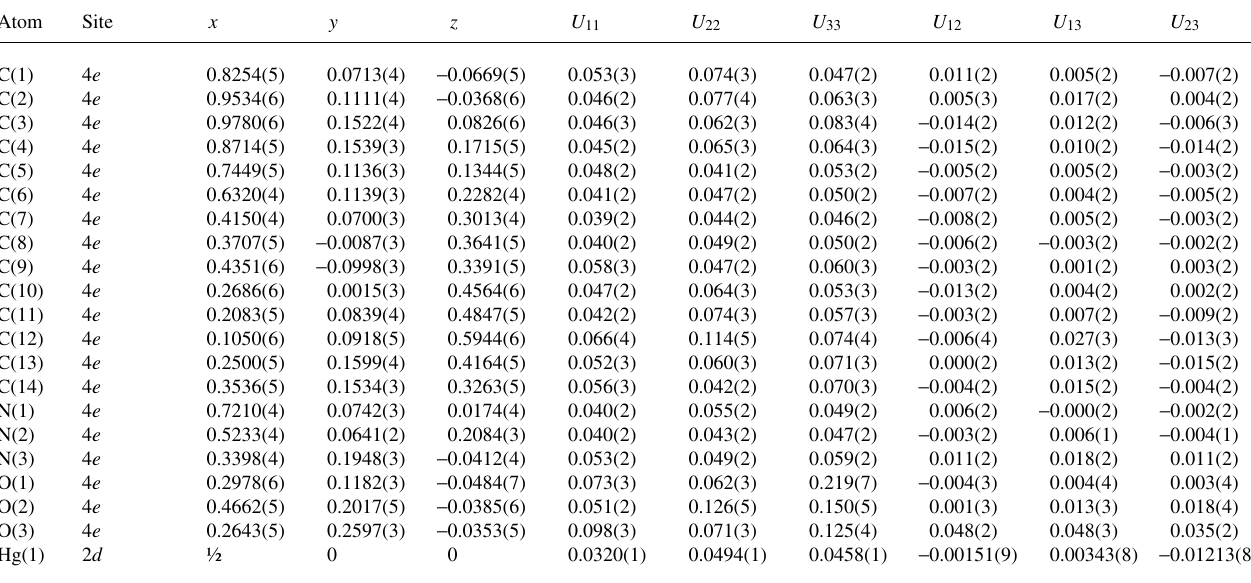
Table 3. Atomic coordinates and displacement parameters (in Å 2 )